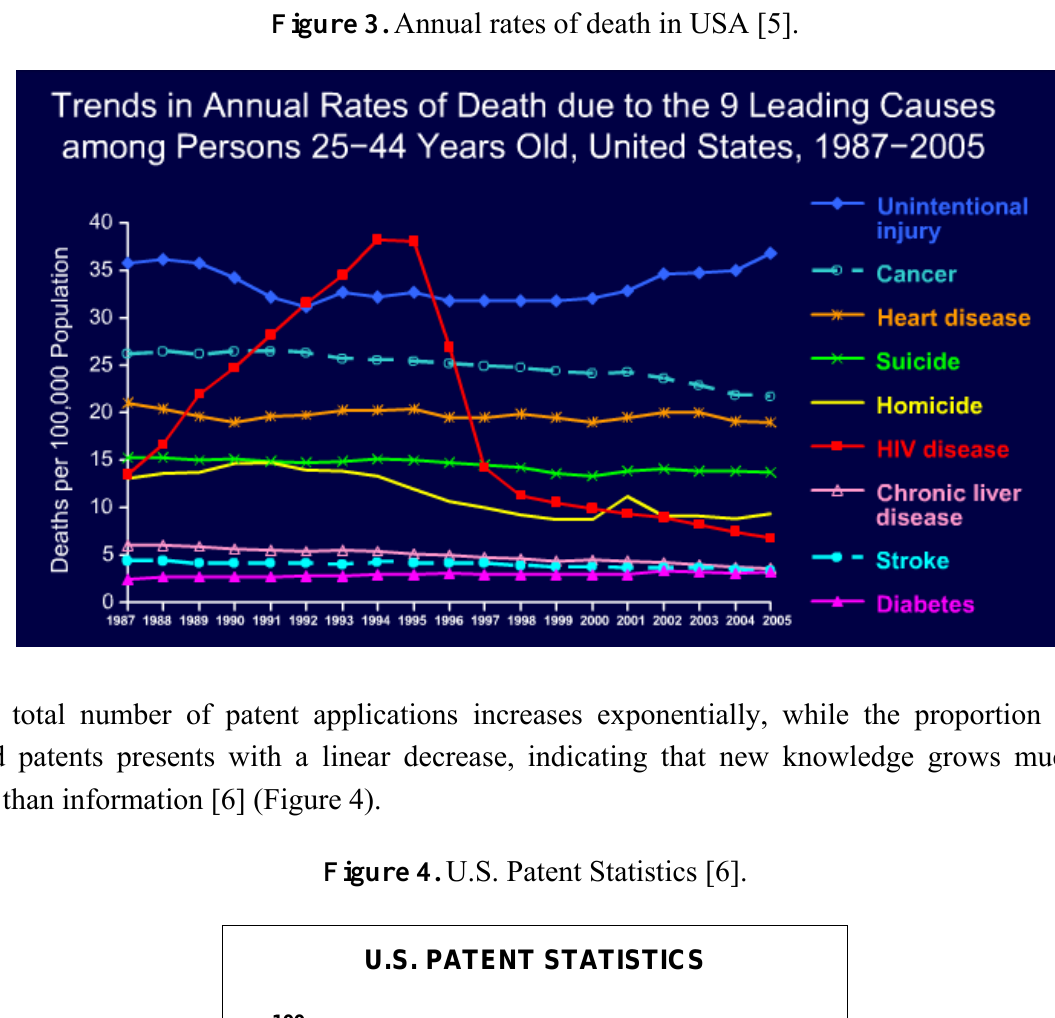
Figure 3. Annual rates of death in USA [5].